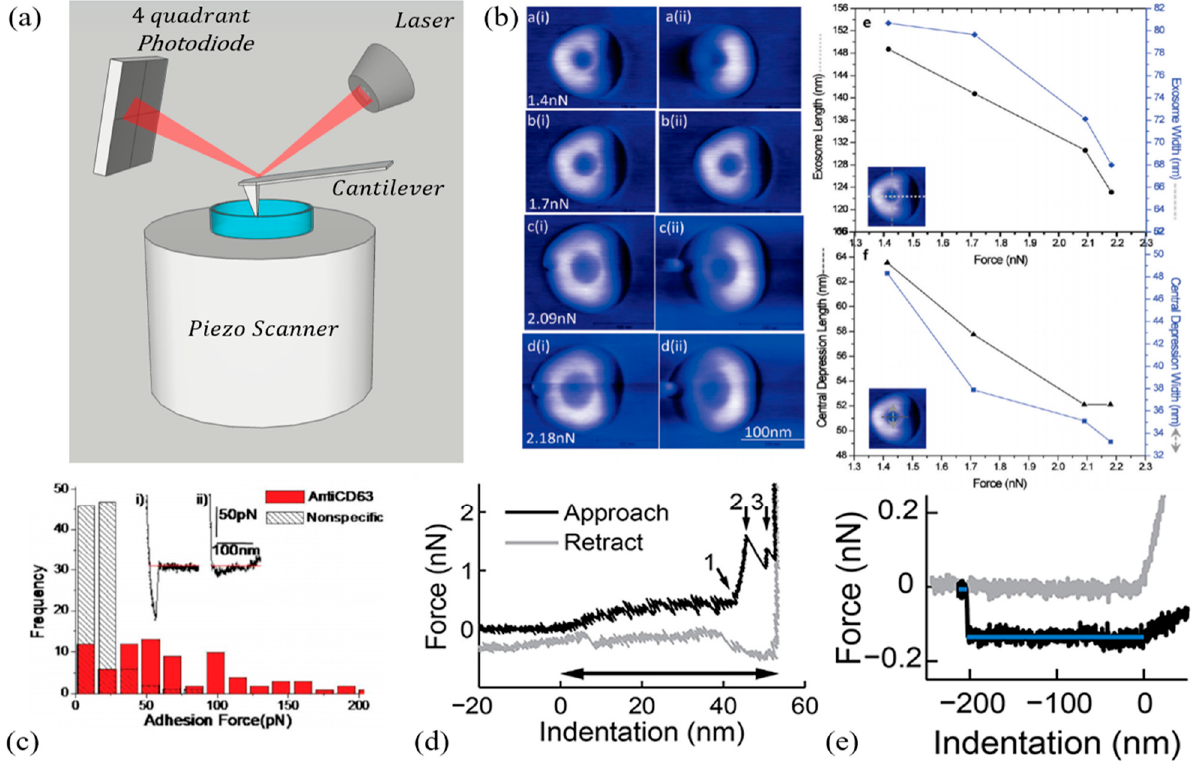
Figure 6. Schematic view of a typical AFM setup ( a ); dependence of the exosome shape on AFM applied force in the range 1.4–2.4 nN ( b ) and specific adhesion on exosome expression CD63 ( c ). Reprinted with permission from ref [190]. Copyright ACS (2010). A typical shape of a correct indentation curve on exosomes ( d ) together with the mechanical signature of EXO membrane tethering ( e ). Reprinted with permission from ref [174]. Copyright Frontiers (2020).